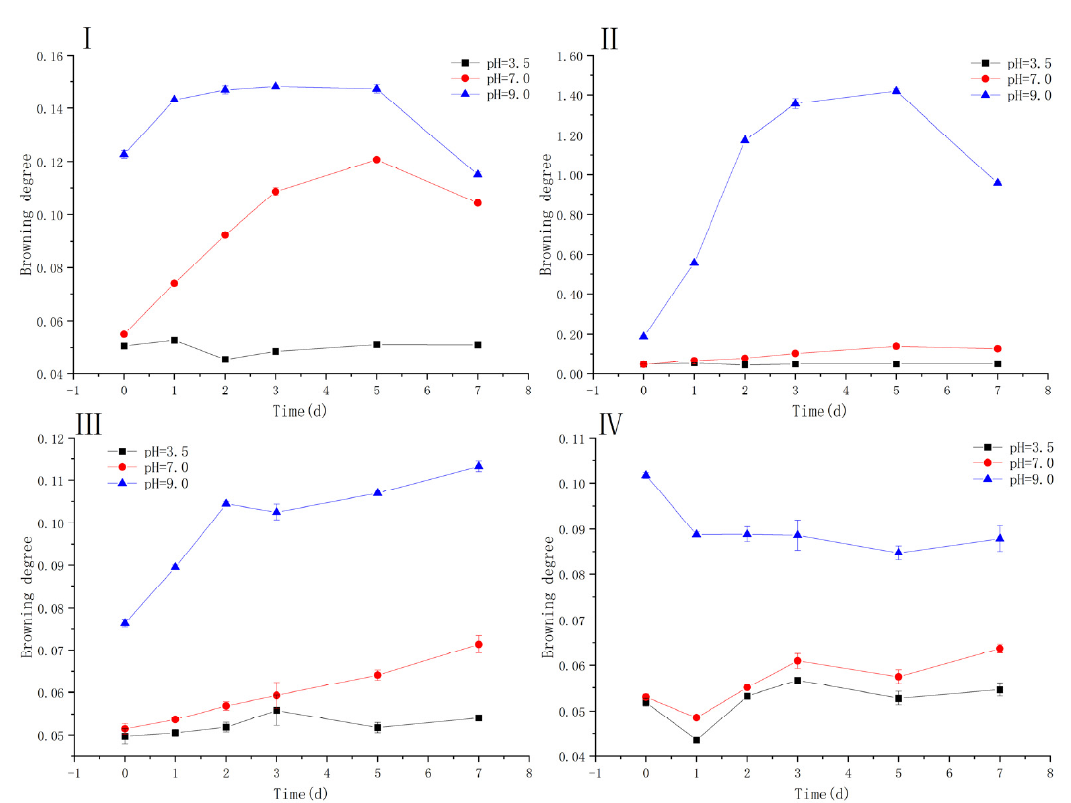
Figure 1. The browning degree of autoxidation products of ( I ) Catechin ( II ) Epicatechin ( III ) Caffeic acid ( IV ) Chlorogenic acid in various values of pH.